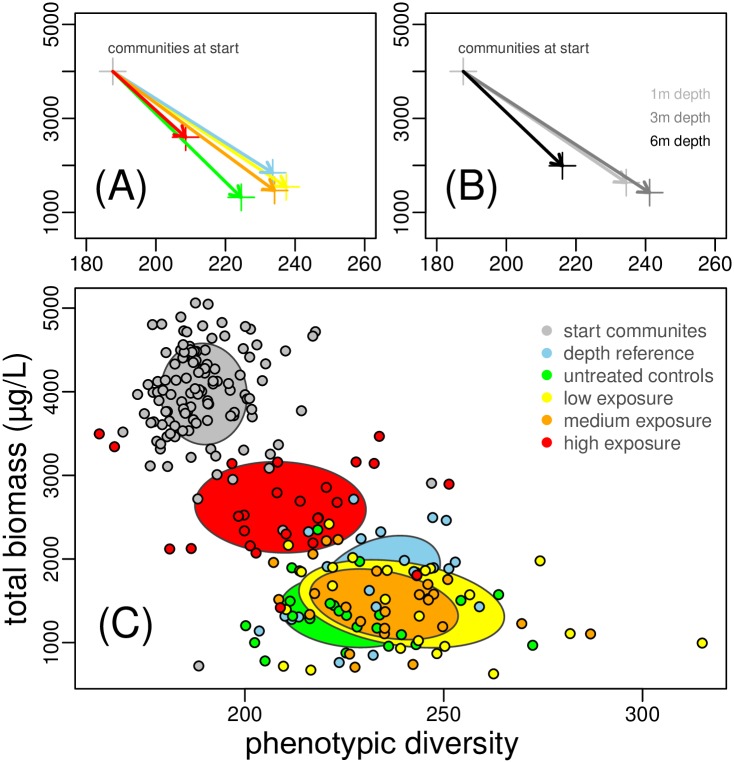
Effects of increasing micropollutant exposure (A-C) and depth (B) on phytoplankton phenotypic diversity and total biomass in experimental communities at the beginning and at the end of the experiment.A-B) arrows connect centroids of each set of treated communities highlighting temporal changes (axes labels as in C); C) ellipses denote 95% confidence intervals for each set of treated communities.